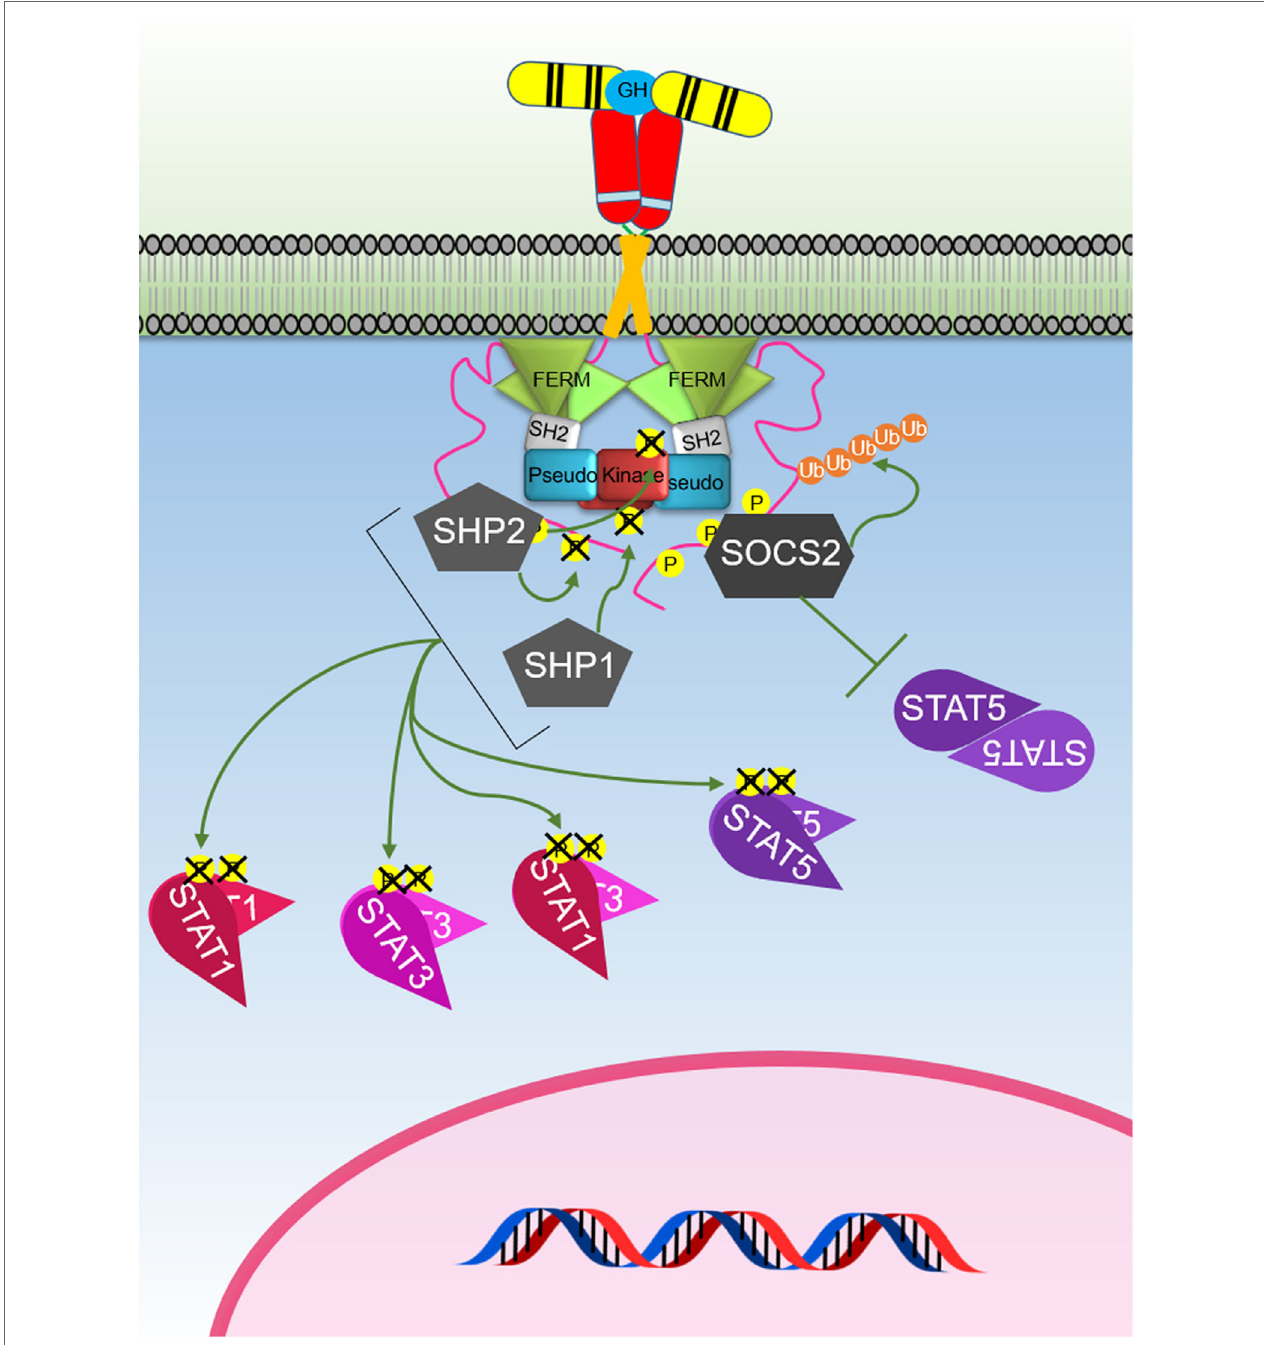
FiGURe 5 | The major negative regulation of growth hormone receptor (GHR) signaling. GH-activated GHR results in suppressor of cytokine signaling (SOCS) 2 binding to a phosphorylated tyrosine on the GHR intracellular domain. This blocks signal transducer and activator of transcription (STAT) 5 binding and induces ubiquitination of the GHR leading to targeted degradation of the receptor. SHP1 and SHP2 act to dephosphorylate and inactivate Janus kinase 2 and STATs, while SHP2 is known to also dephosphorylate the